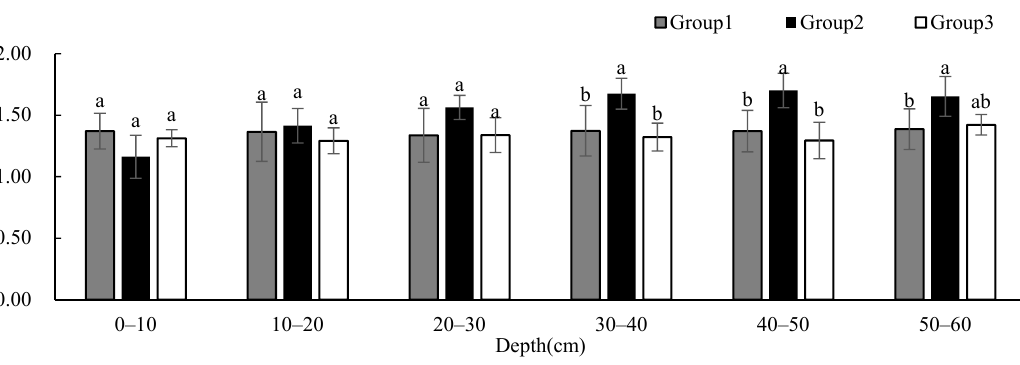
Figure 3. One-way ANOVA results of SBD under different vegetation cover types at different depths (different letters denote significant differences; p < 0.05; a > b).